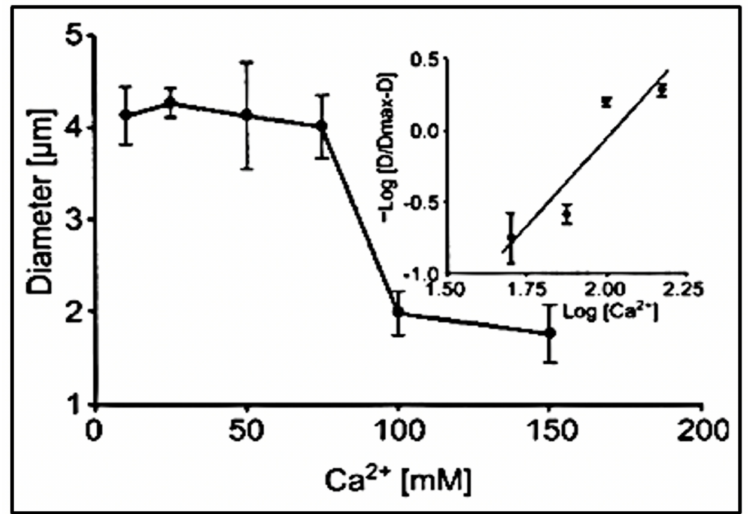
Figure 9. The diameter of swollen exocytosed gels—equilibrated in a pH 3 buffer solution—changes drastically as [Ca 2+ ] increased from 10–150 mM CaCl 2 . It undergoes a characteristic transition to a condensed phase [19]. It shows a steep inflection at a critical point between 60 and 100 mM CaCl 2 at which phase transition takes place. The process is reversible, and as shown by the Hill plot in the inset, it exhibits the characteristic high cooperativity of critical phenomena with a Hill coefficient >2.5. Point corresponds to the mean ± SEM of seven